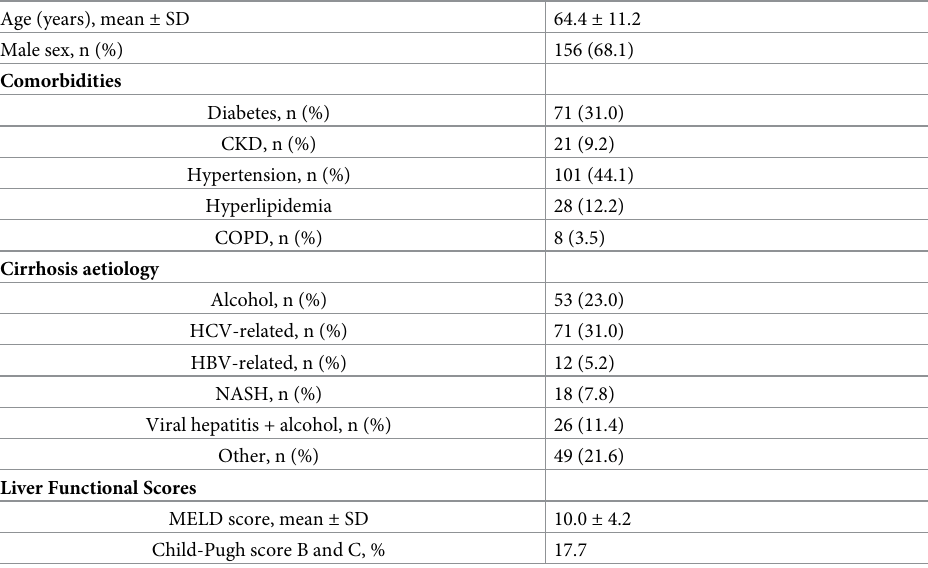
Table 1. Baseline characteristics of the population at the enrolment (N: 229